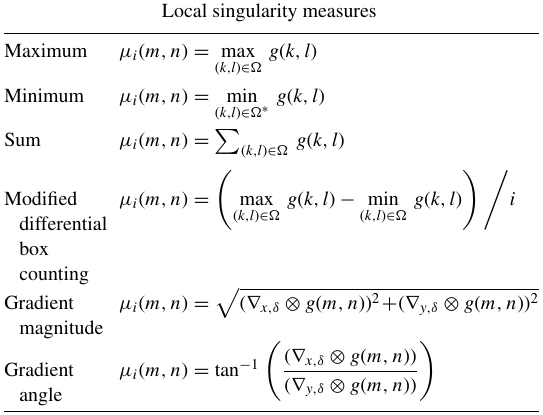
Local singularity